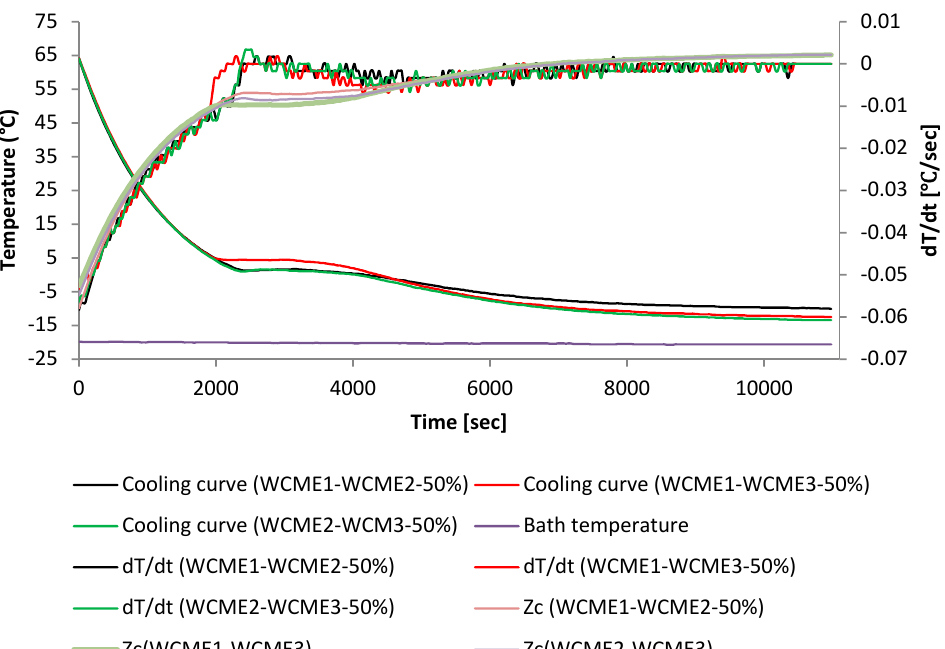
Figure 9. Cooling curve analysis and rate of change of temperatures with respect to time for all pure biodiesels